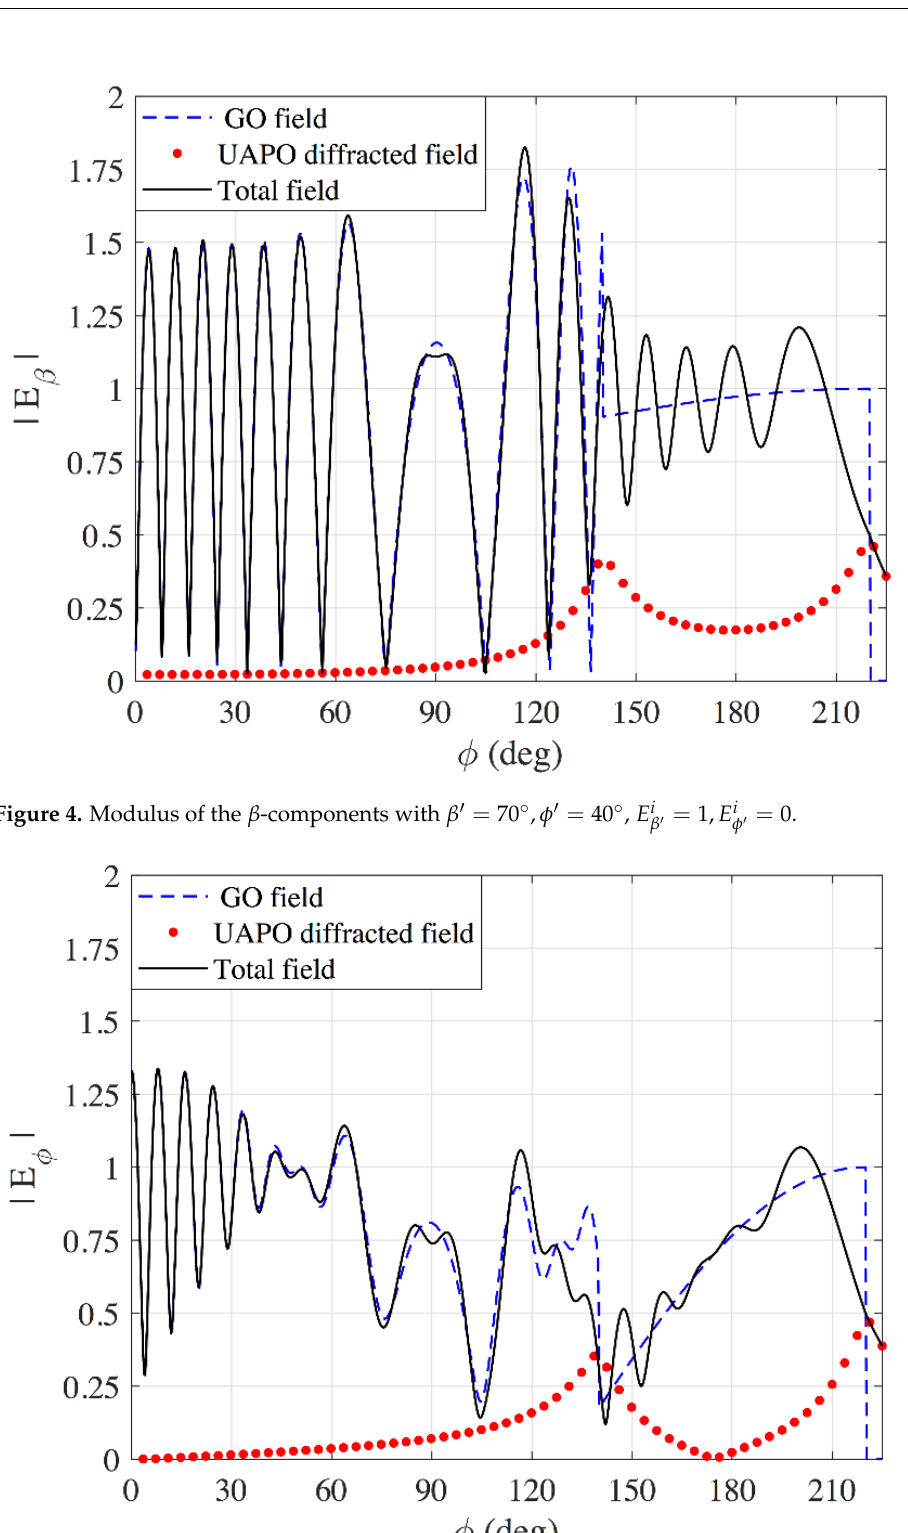
i = i = = 0, E i = 0, E 1 . Figure 5. Modulus of the ϕ -components with β (cid:48) = 70 ◦ , φ (cid:48) = 40 ◦ , E i φ (cid:48) β (cid:48) b ' f ' i = i = 0, E 1 . b ' f '